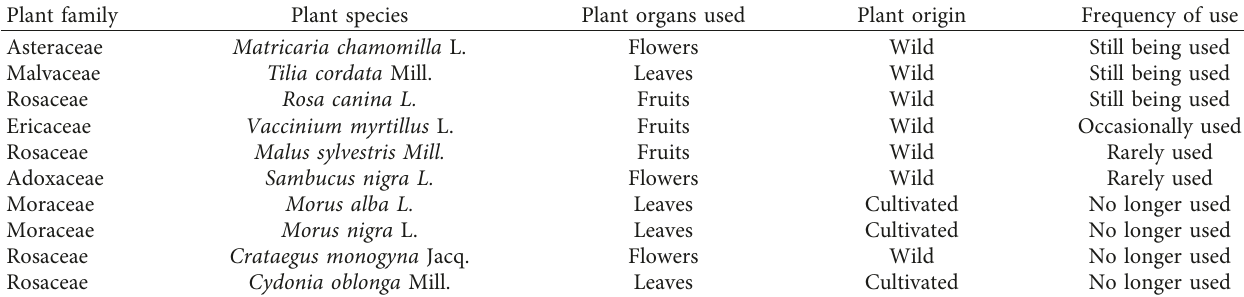
Table 1: List of the selected plant species used for tea